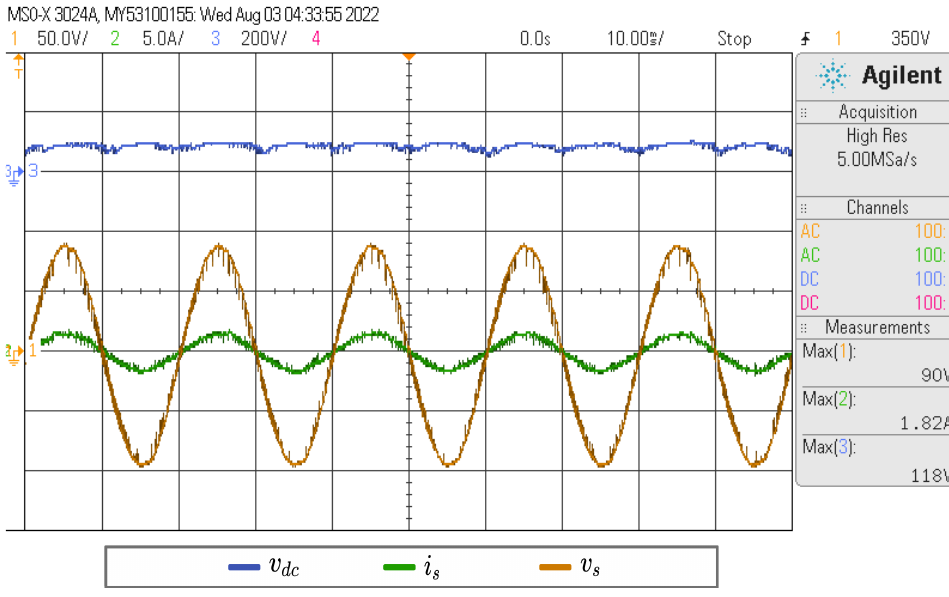
Figure 9. Waveforms of voltage and current in the